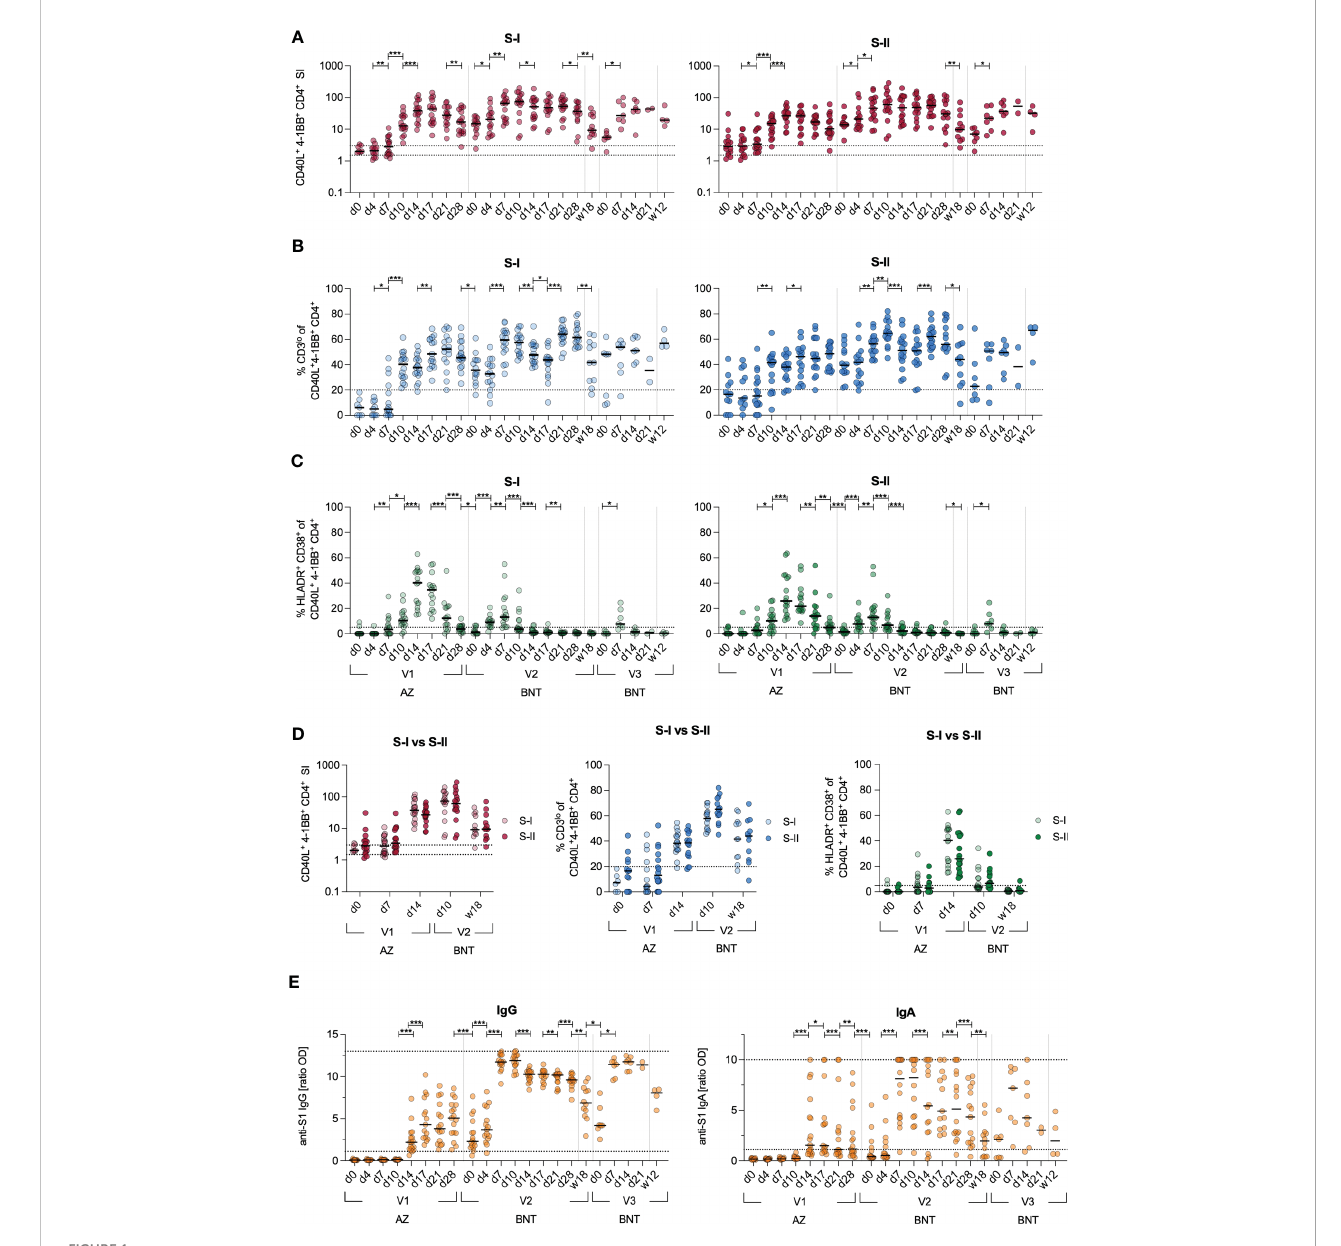
FIGURE 1 Kinetics of adaptive immune responses upon heterologous vaccination. Immune response kinetics following heterologous SARS-CoV-2 vaccination of unexposed young healthy donors (n=17) vaccinated with AZ at d0, then BNT 85(+/-3) days after fi rst dose and 142(+/-7) days after second dose. (A) Ex vivo stimulation of PBMCs with S-I and S-II peptide pools. The percentage of CD40L+4-1BB+ within CD4+ T cells among stimulated PBMCs was divided by the percentage of these cells in the unstimulated control, resulting in the stimulation index (SI). Dotted lines indicate a SI of 1.5 and 3, separating non- responders from responders with uncertainty and de fi nite responders. (B) Frequencies of CD3lo cells among S-I- or S-II-reactive CD40L+4-1BB+ CD4+ T cells of T cell responses with a SI ≥ 1.5. (C) Frequencies of HLA-DR+CD38+ among CD40L+4-1BB+ CD4+ T cells. (D) Direct comparison of the SI, frequencies of CD3lo and HLA-DR+CD38+ cells of CD40L+4-1BB+ CD4+ T cells at indicated time points upon stimulation with S-I or S-II peptide pools. (E) Serum anti-SARS-CoV-2 S1 IgA and IgG titer ratios. Only signi fi cant differences are shown with *p < 0.05, **p<0.01, ***p<0.001 (A-C, E-F: Wilcoxon matched-pairs signed-rank test between consecutive days, D: Mann-Whitney test). SI below 1 were excluded from further analysis, as they are below the lower limit of detection. Black line indicates the